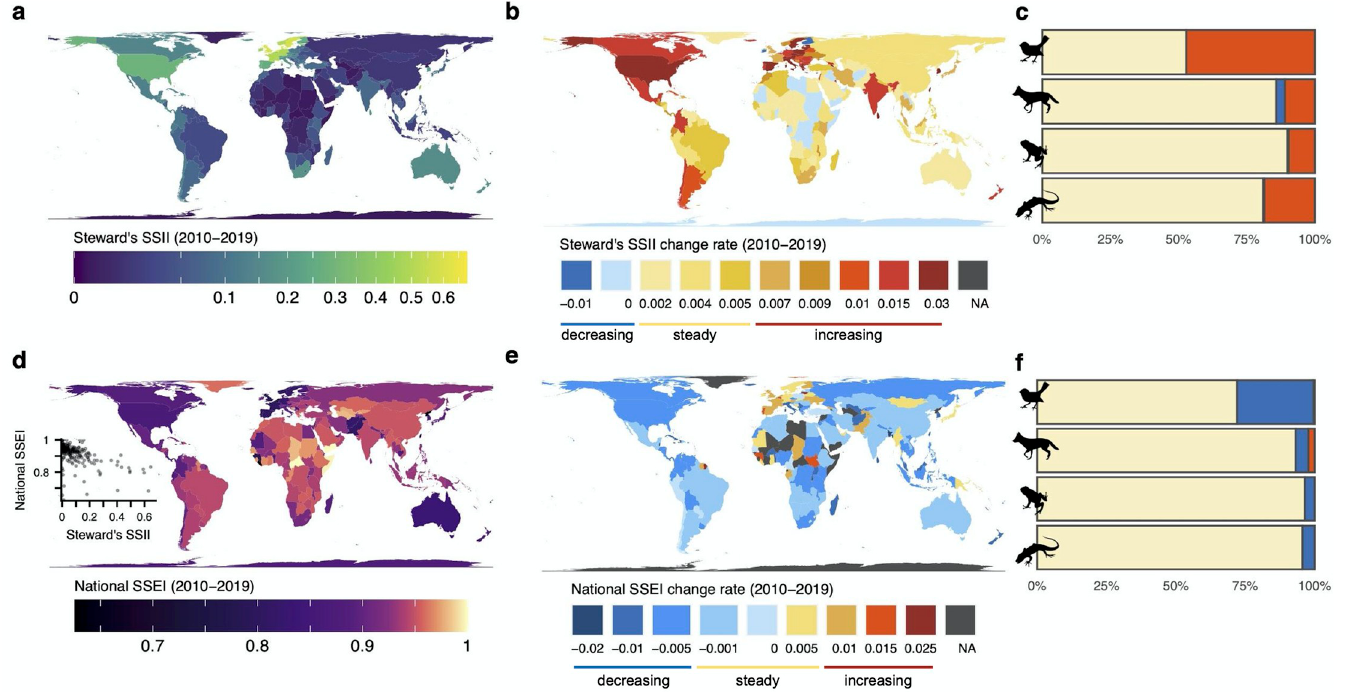
Fig 4. National patternsand trendsin spatial biodiversity data coverage and samplingeffectiveness. ( a,d )MeanSteward’s SSII ( a )and NationalSSEI ( d )overthe previous decade (2010–2019) averagedacrossterrestrial vertebrates; the relationship betweendata coverageand sampling effectivenessis shown as inset.( b,e )Changerate in Steward’s SSII ( b )and NationalSSEI ( e )overthe previousdecade. Maximumvalues for each color bin are labeled beloweach map. ( c,f )Percentage of nations with no significant ( p < 0.01) trends(beige) and significant decreasing(blue) or increasing (red) trends in Steward’sSSII ( c )and SSEI ( f )over the previous decade for birds, mammals, amphibians, and reptiles. Artwork from phylopics . org(see Text A in S1 File).National boundaries from gadm . org . The data underlying this figure may be found in https://mol.org/ indicators/coverage and https : //github . com/MapofLife/biodiversity-data-gaps .SSEI, Species Sampling Effectiveness Index; SSII, SpeciesStatus Information Index.